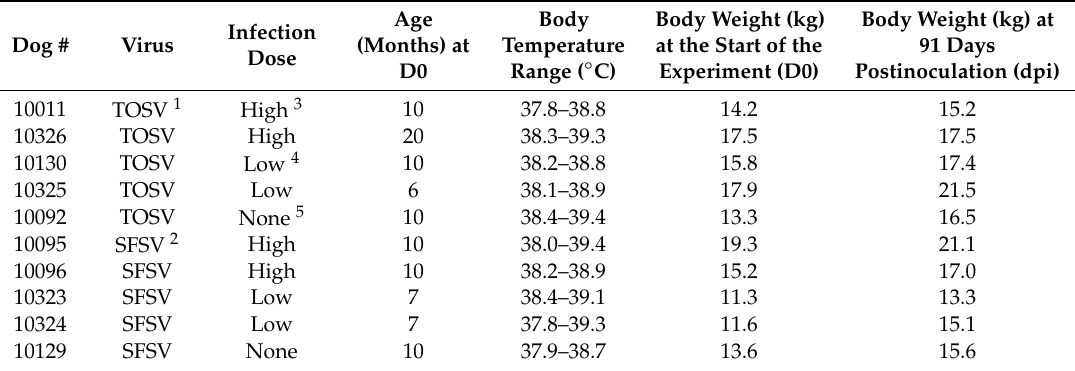
Table 1. Types and doses of virus inoculated into dogs and their ages, body temperatures ( ◦ C), and weights (kg) during the